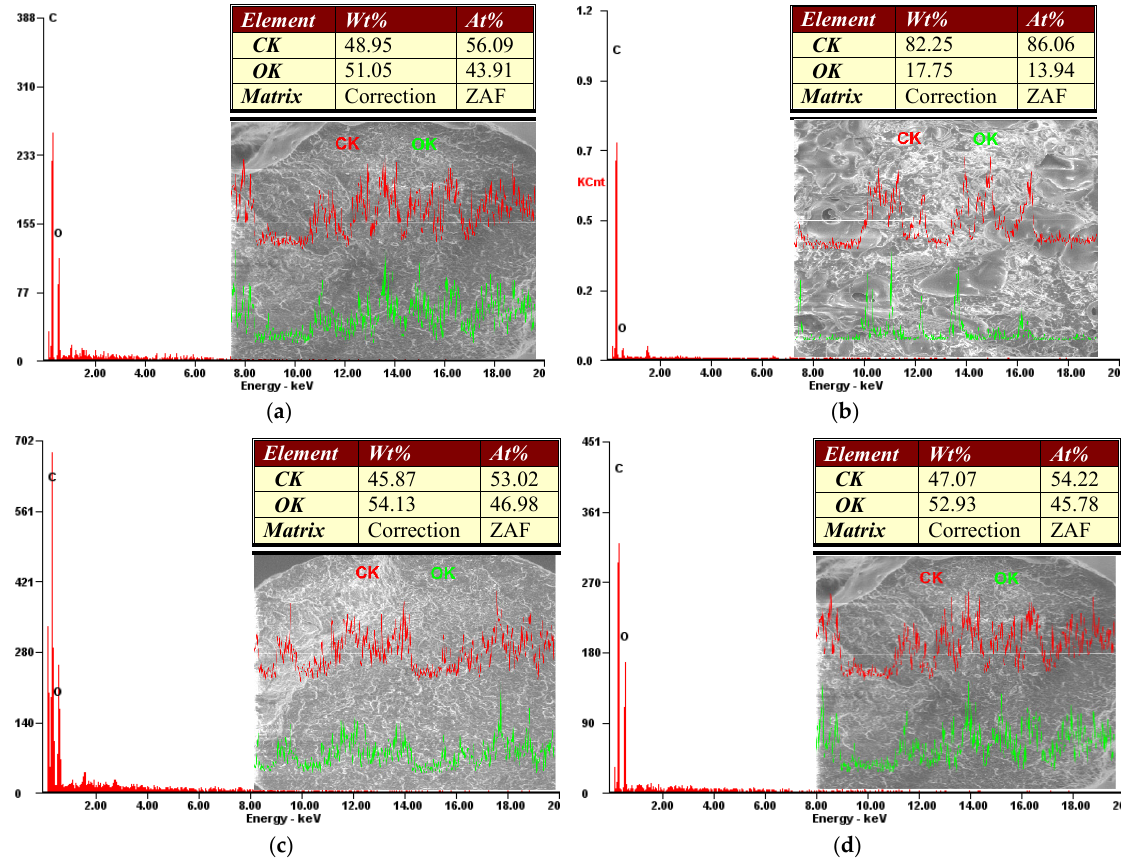
Figure 2. The EDAX (Energy Dispersive X-ray Analysis) wire images: ( a ) Arboblend V2 Nature, ( b ) Arbofill Fichte, ( c ) Arboblend V2 Nature reinforced with Extrudr BDP “Pearl”, ( d ) Fiber Wood.